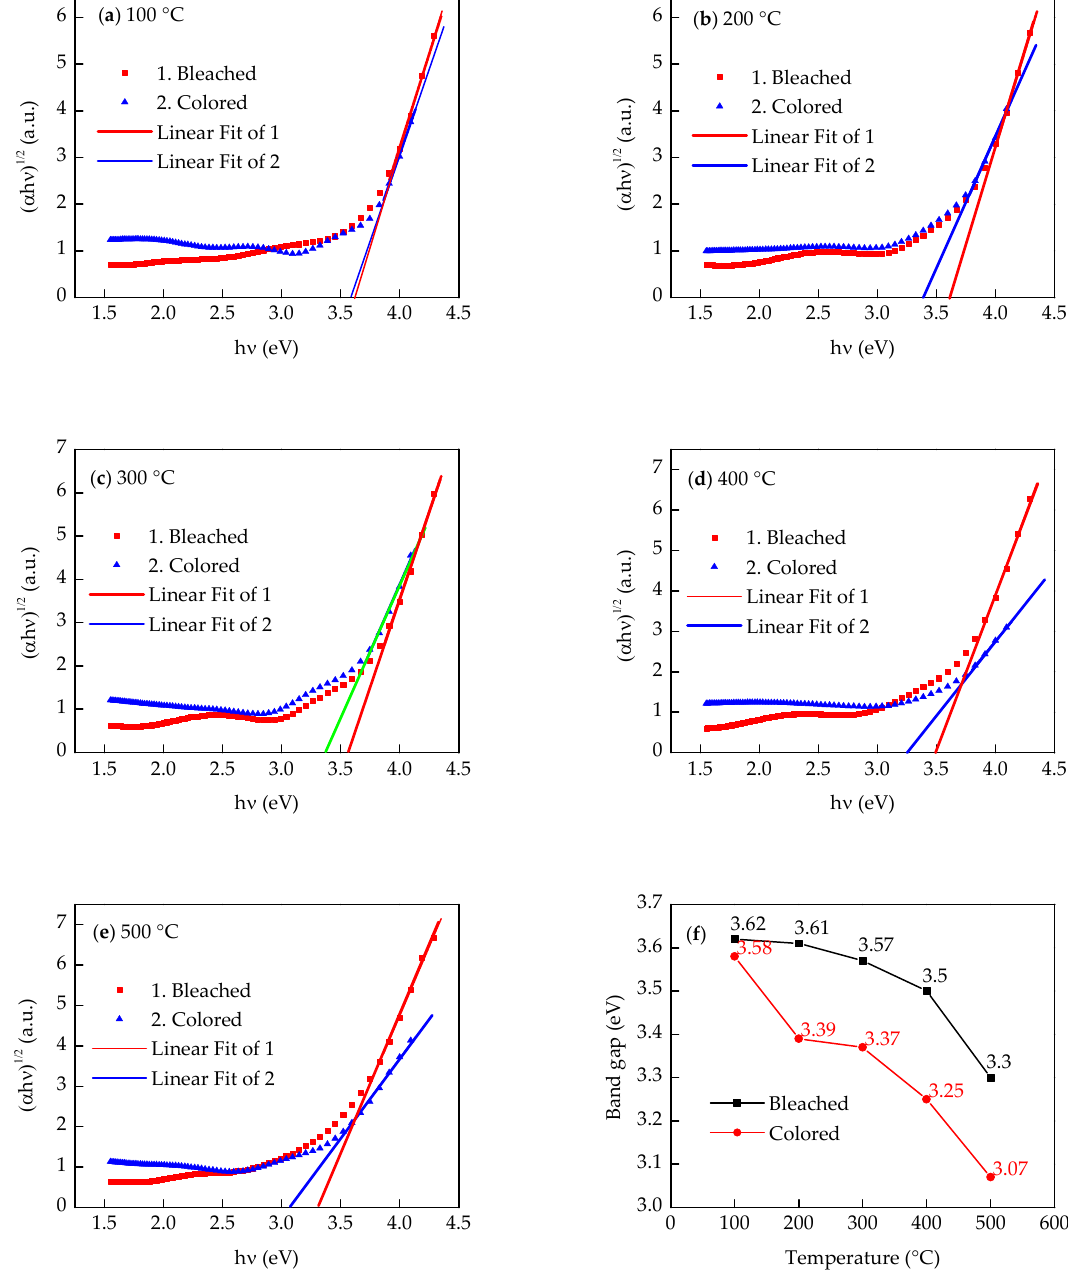
Figure 3. Optical band gap energy of WO 3 films in a colored state and bleached state. ( a ) 100 °C; ( b ) 200 °C; ( c ) 300 °C; ( d ) 400 °C; ( e ) 500 °C; and ( f ) a comparison of optical band gap energy of WO 3 films annealed at different temperature and electrochromic state (colored and bleached).